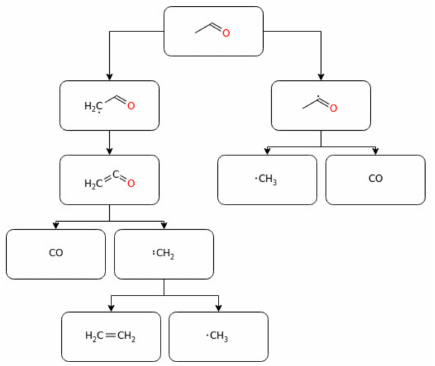
Figure 13. A simplified reaction pathway for acetaldehyde